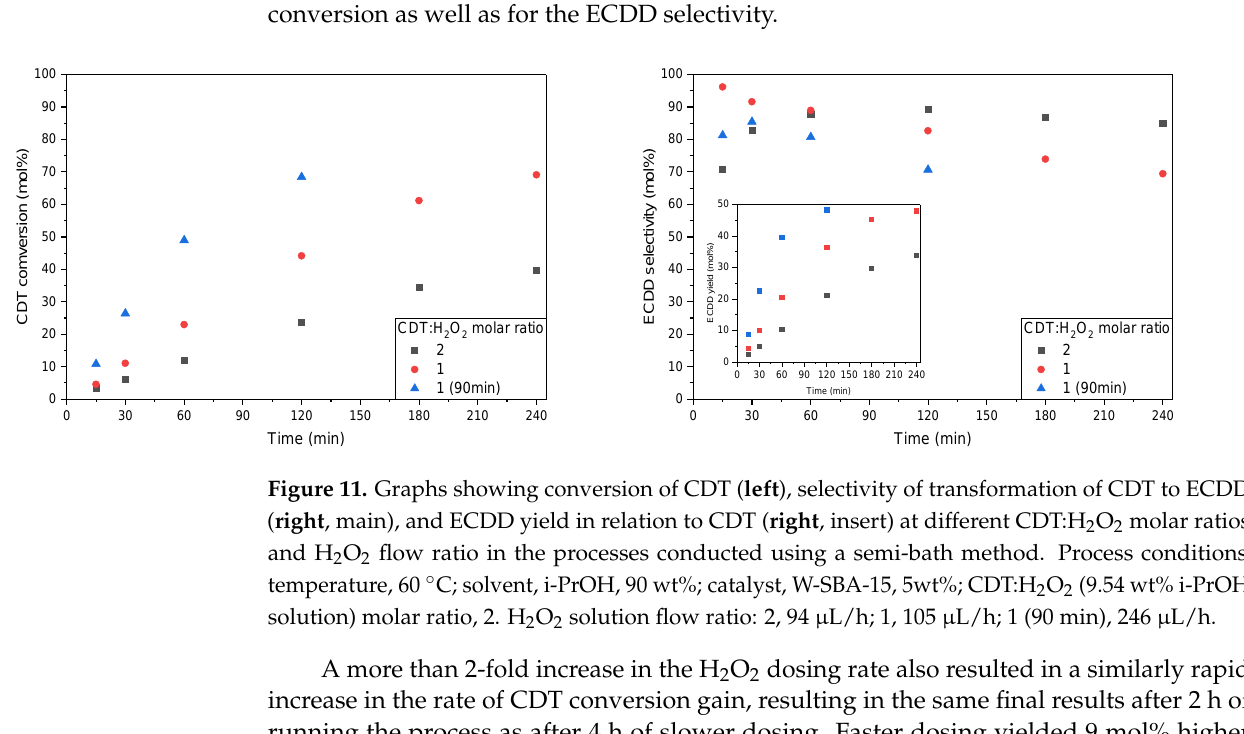
Figure 10. Graphs showing conversion of CDT ( left ), selectivity of transformation of CDT to ECDD ( right , main), and ECDD yield in relation to CDT ( right , insert) at different catalyst contents in the processes conducted using a semi-bath method. Process conditions: temperature, 60 °C; solvent, i-PrOH, 90 wt%; catalyst, W-SBA-15; CDT:H 2 O 2 (9.54 wt% i-PrOH solution) molar ratio, 2.